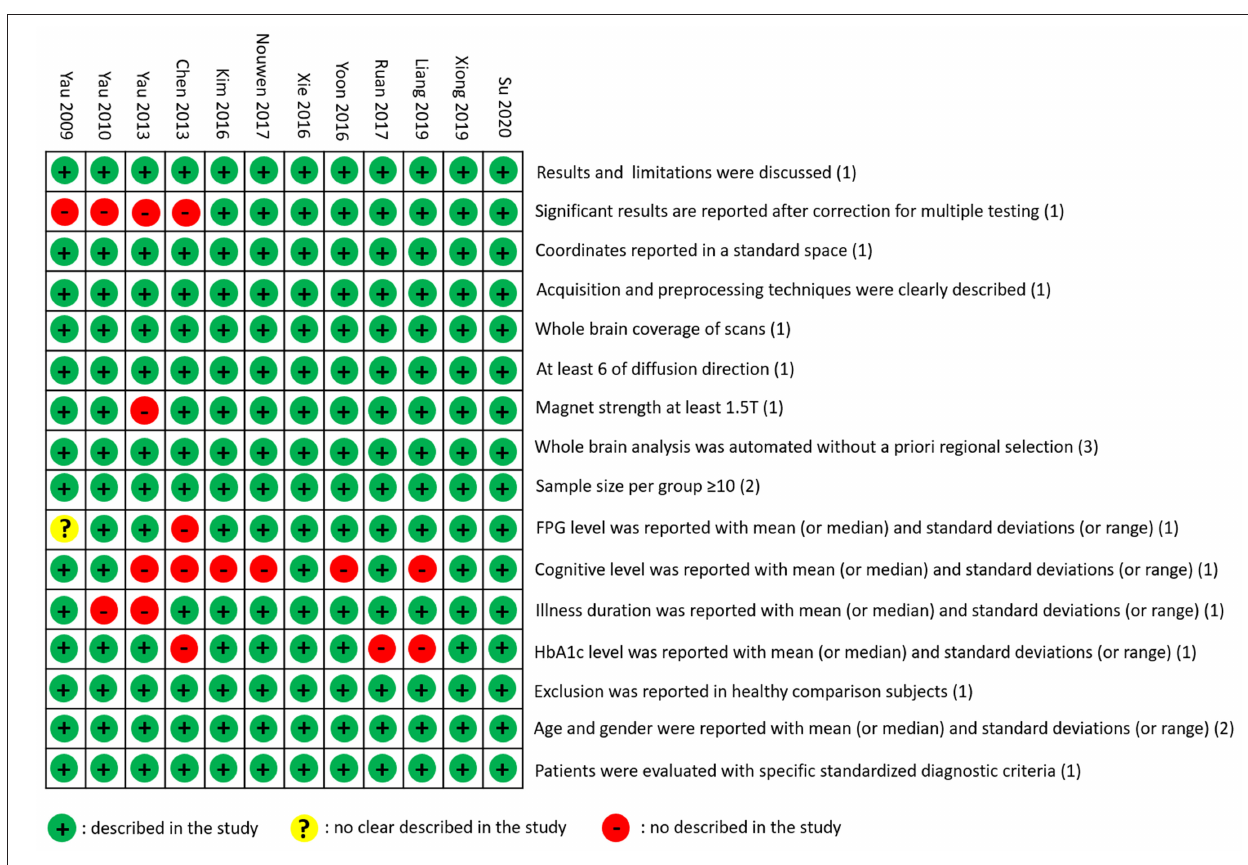
FIGURE 2 | Literature quality assessment. The green circle means the information is clearly described in the study. The yellow circle means the information is not clearly described in the study. The red circle means the information is not described in the study.